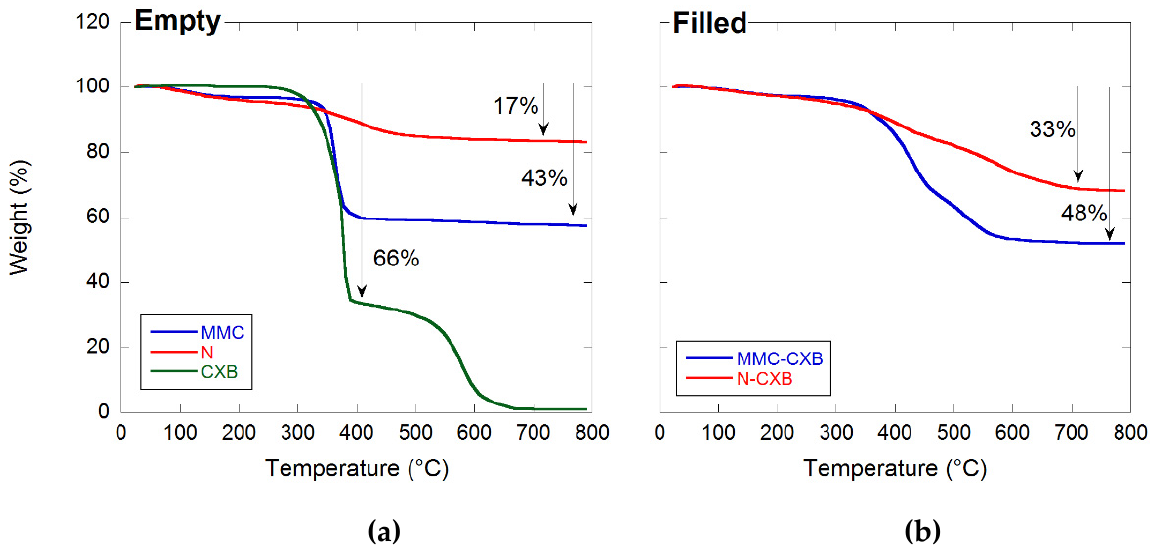
Figure 4. TGA curves for free CXB and the two ( a ) empty and ( b ) filled carrier materials.